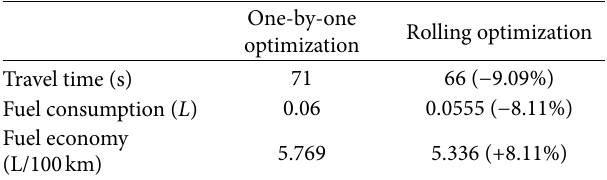
Table 5: Fuel consumption and travel time of the rolling optimiza- tion and the one-by-one